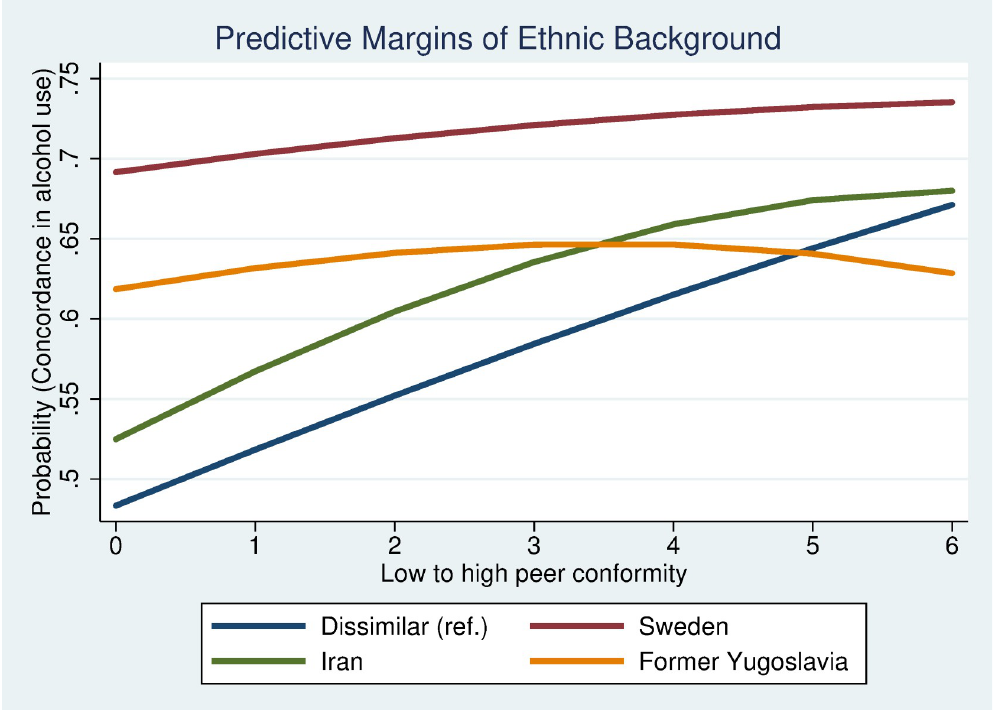
Fig 2. Concordance in alcohol habits by conformity in peer